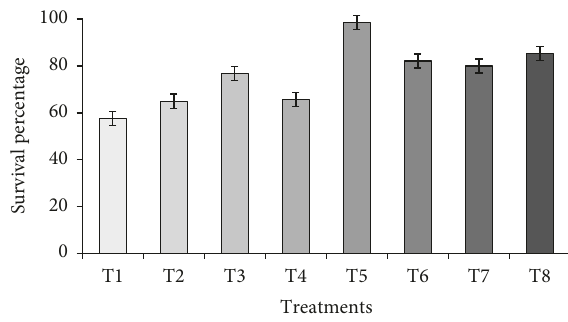
Figure 1: Influence of different organic and inorganic fertilizer regimes on survival percentage (%) of strawberry cv. Chandler. T 1